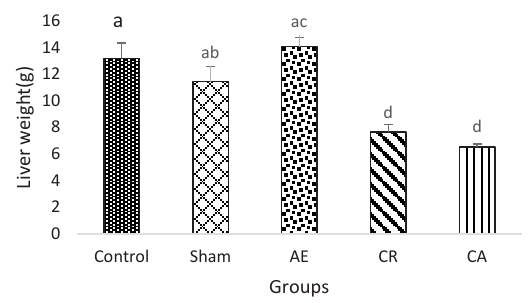
Figure 1. CR and CA reduces liver weight. Note. AE: Aerobic exercise; CR: Caloric restriction; CA: Caloric restriction-aerobic exercise. Dissimilar acronyms indicate significant